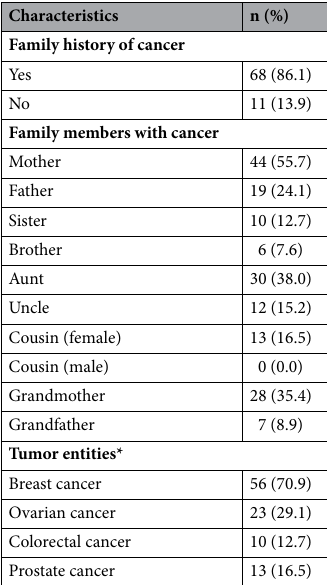
Table 2. Descriptive statistics of family history of cancer. *Refers to the general presence of a specific tumor entity within a family. It is possible that several family members were affected by this type of cancer.